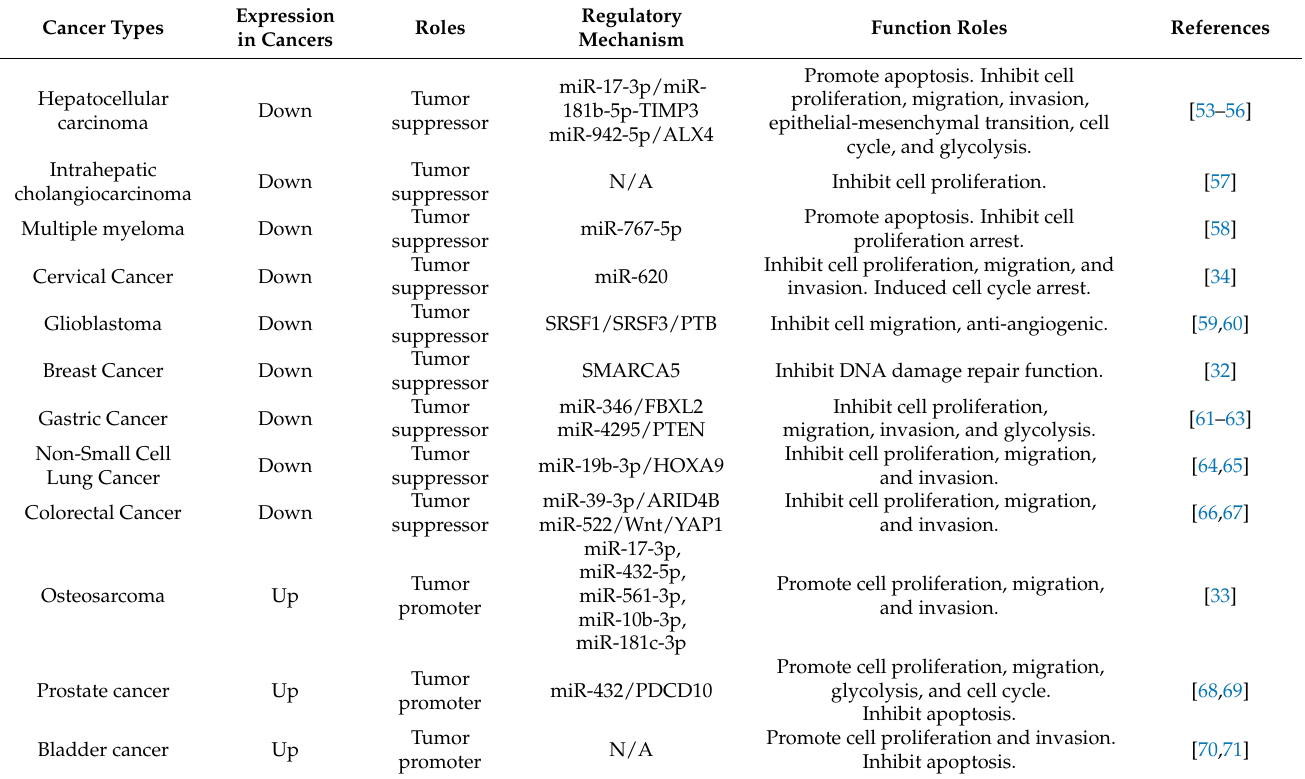
Table 1. Functional characteristics of circSMARCA5 in multiple human